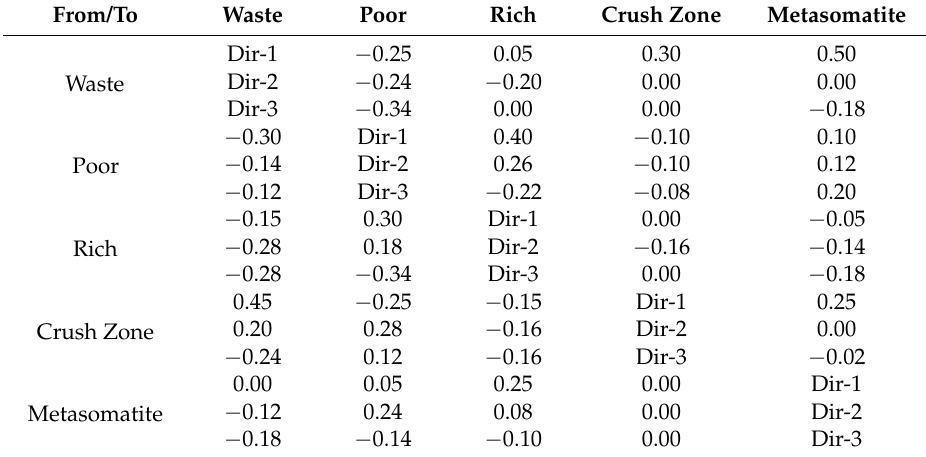
Table A1. Preferentiality values. Each cell contains one value per direction from top to bottom: N–S, W–E and vertical directions.